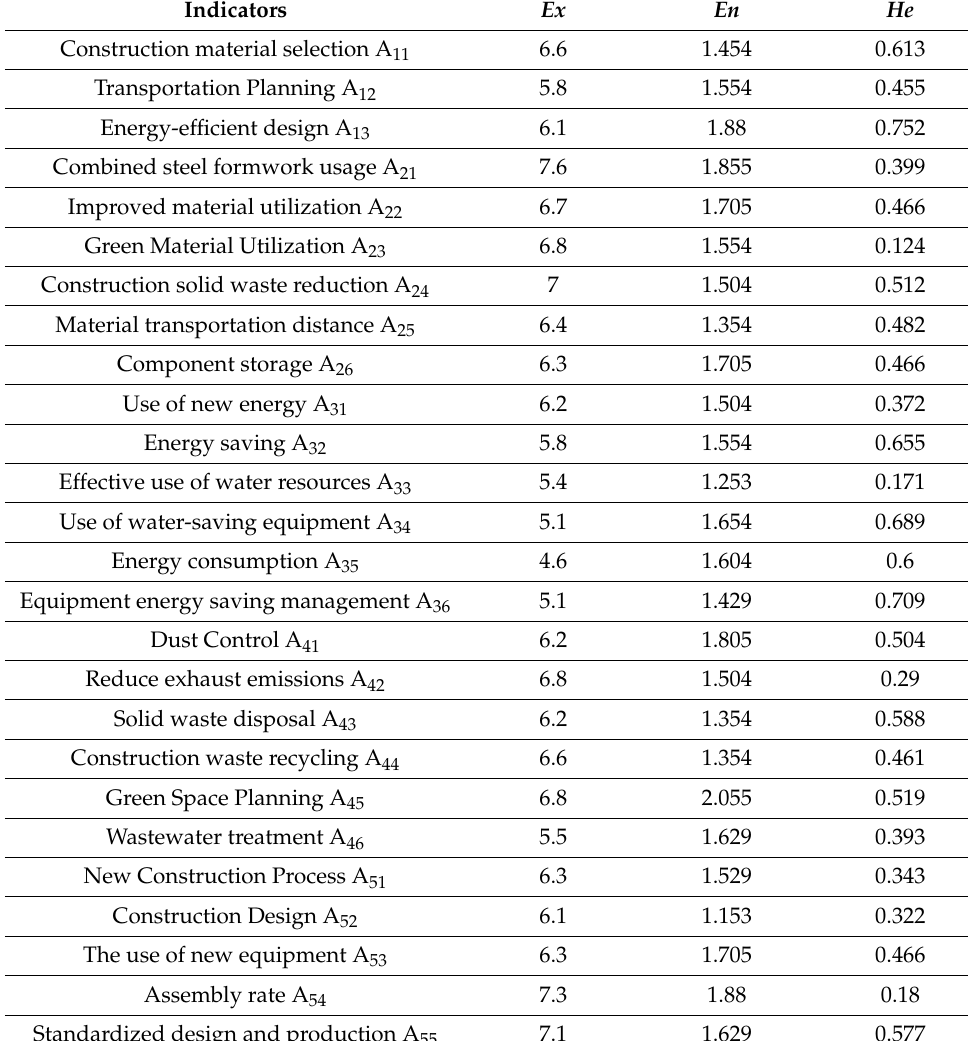
Table 6. Numerical characteristics of the indicator layer.